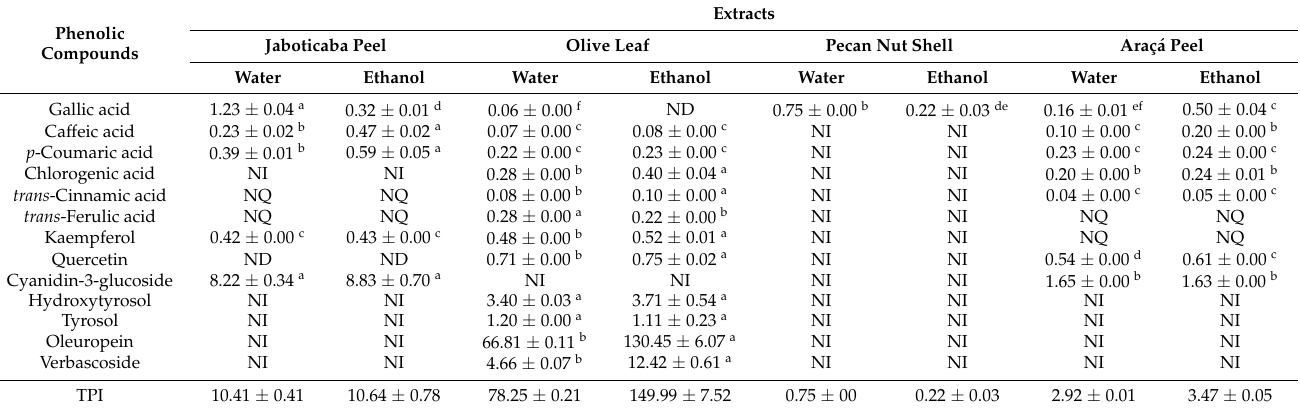
Table 4. Phenolic compounds (mg g − 1 , d. w.) of the natural extracts (mean ± SE, n = 4). Extracts Phenolic Jaboticaba Peel Olive Leaf Pecan Nut Shell Araç á Peel Compounds Ethanol Water Ethanol Water Ethanol Water